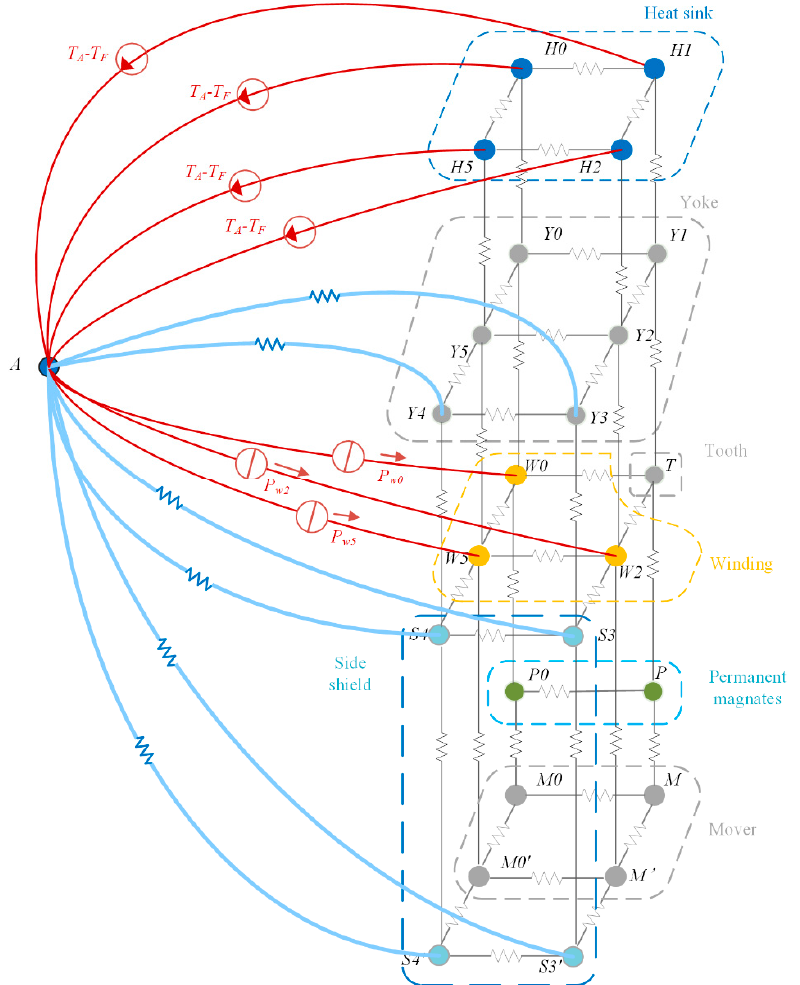
Figure 8. Three-dimensional thermal network including heat sink nodes. Reprinted with permission from ref. [81]. Copyright 2015 IEEE.